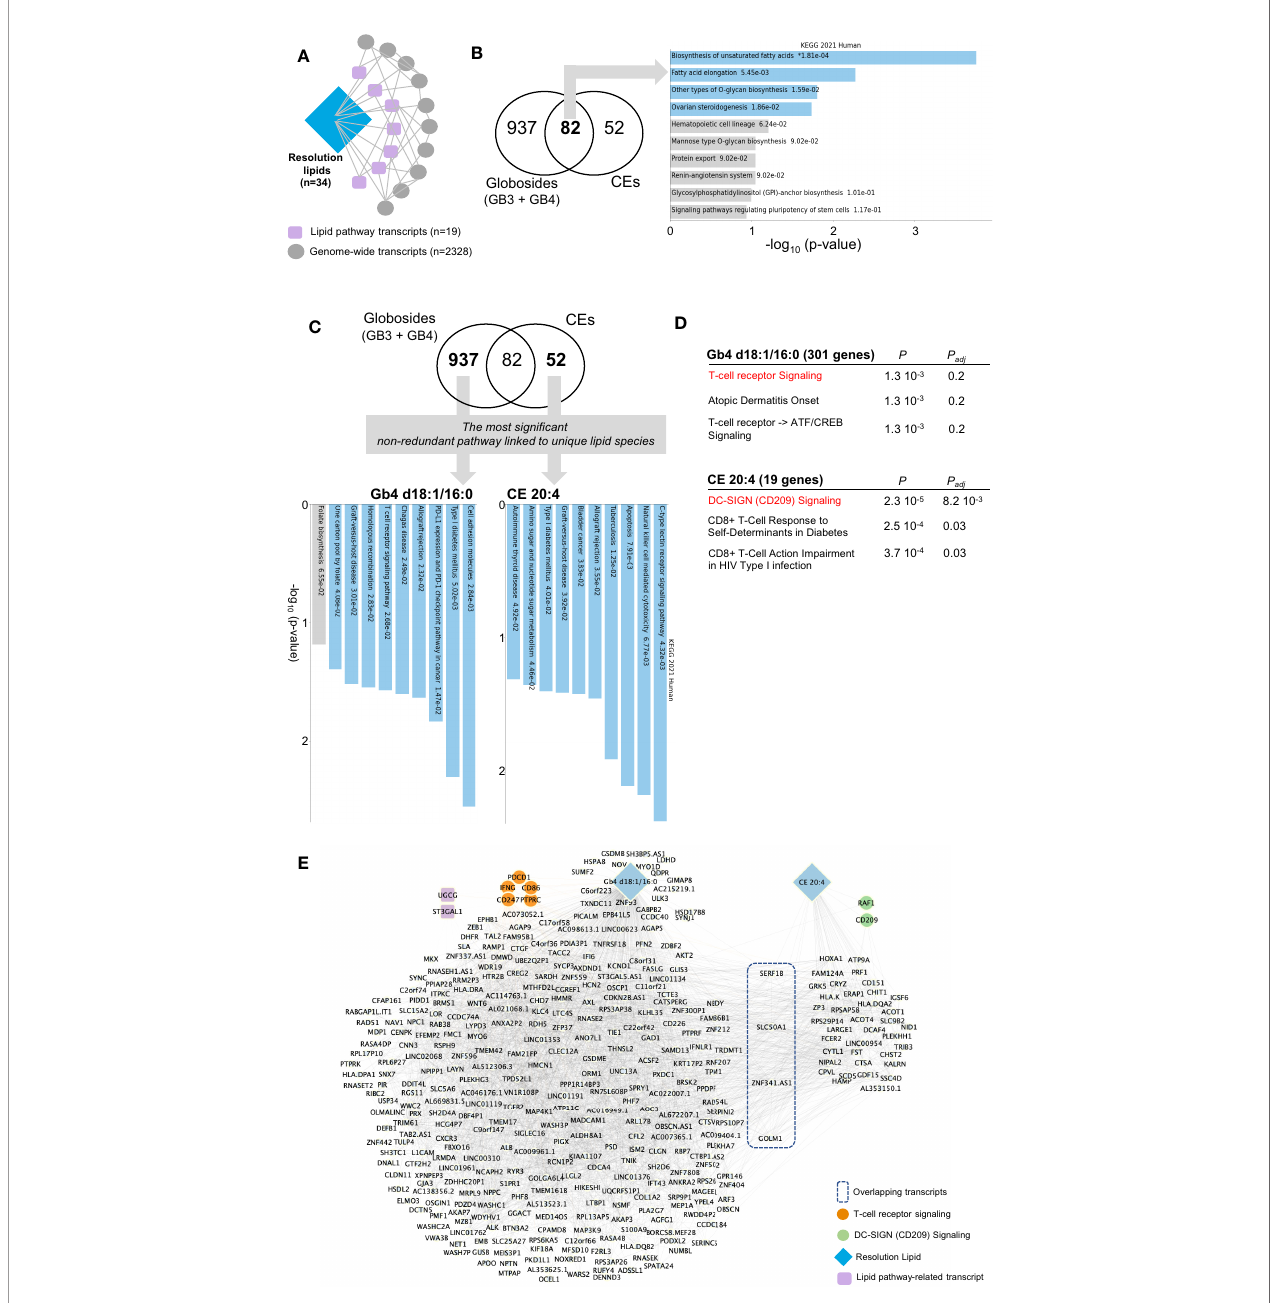
FIGURE 5 | Network analysis by partial correlation identi fi es speci fi c pathways associated with the resolution phase lipids. (A) Schematic for partial correlation between resolution lipids, lipid pathway transcripts and genome-wide transcripts. The n denotes the number of genes/lipids retained after the fi ltering process applied in partial correlation. (B) Venn diagram showing partially correlated genes with globosides (Gb3 and Gb4) and cholesteryl esters (CE). Pathway analysis on the shared 82 genes is shown on the right panel. (C) Venn diagram highlighting the most signi fi cant non-redundant pathway in globosides and CE. KEGG pathways are shown on the panel below. (D) Elsevier Pathways for Gb4 d18:1/16:0 and CE 20:4. P and P adj denote the P-value and the adjusted P-value, respectively. (E) Network representation based on partial correlation for Gb4 d18:1/16:0 and CE 20:4. For panels (B, C) , the bar chart shows the top 10 enriched terms in the chosen library, along with their corresponding p-values. Colored bars correspond to terms with signi fi cant p-values (<0.05). * next to a p-value indicates the term also has a signi fi cant adjusted p-value